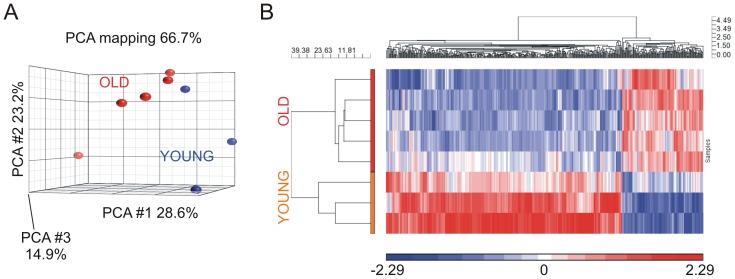
Whole transcript microarray of aging-associated remodeling in porcine left atrium.A. Principal component analysis (PCA) of global transcript expression changes in old (n = 5) versus young (n = 3) swine LA tissue. B. Heat map showing pattern of global transcript expression changes in LA isolated from old (n = 5) versus young (n = 3) swine (only genes showing ≥2-fold change between groups, P<0.05). Positive values (red) indicate genes increased in LA of old swine, negative (blue) indicates decreased expression in LA of old swine.